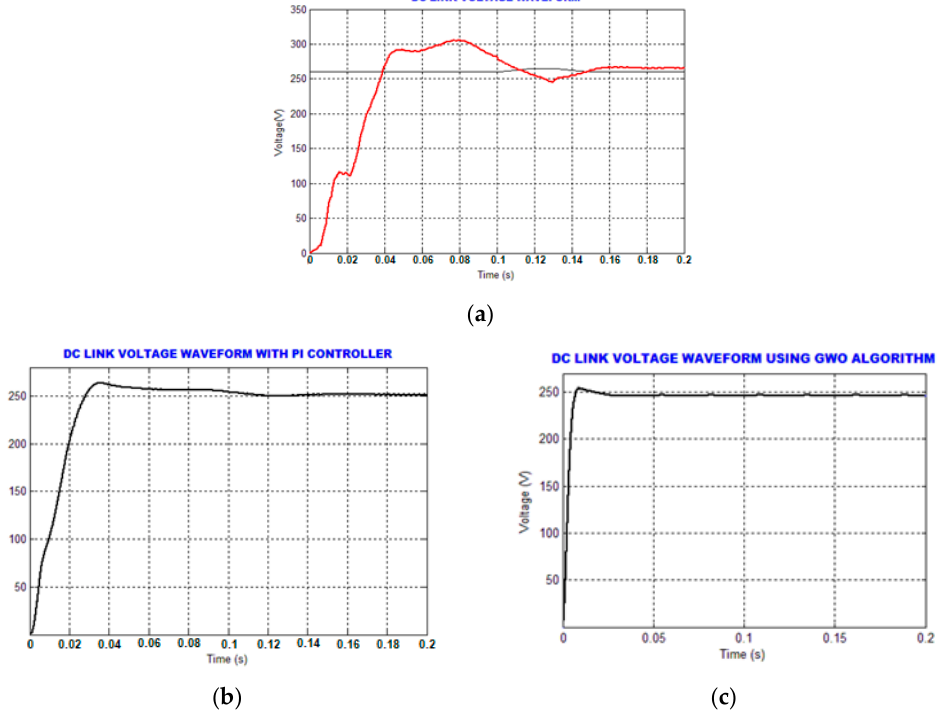
Figure 10. ( a ) DC-link voltage; ( b ) DC-link voltage with PI controller; ( c ) proposed SCDB converter output.